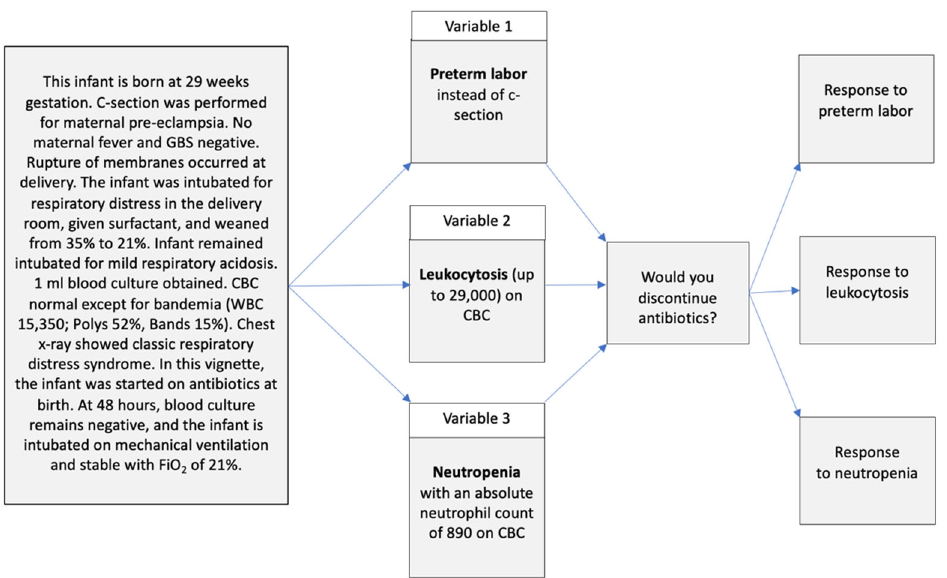
Figure 2. Flow map showing the initial details of a preterm infant case vignette narrative. Prior to the addition of the variables, nearly all respondents chose to discontinue antibiotics. Three variables are each independently added to the narrative to isolate the impact of each variable alone on the decision to discontinue antibiotics.